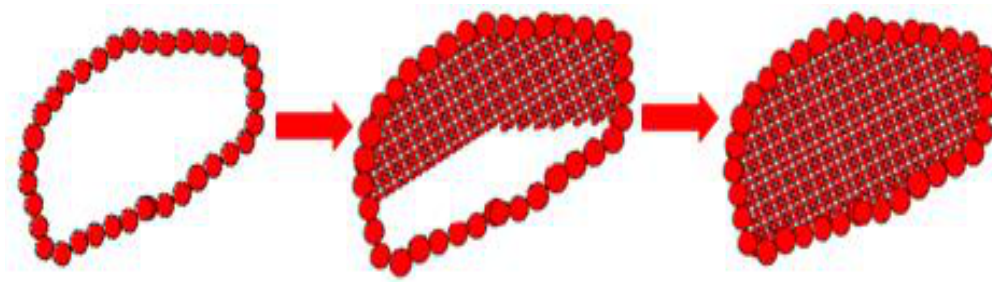
Figure 5. Procedure of the virtual particles’ modeling.